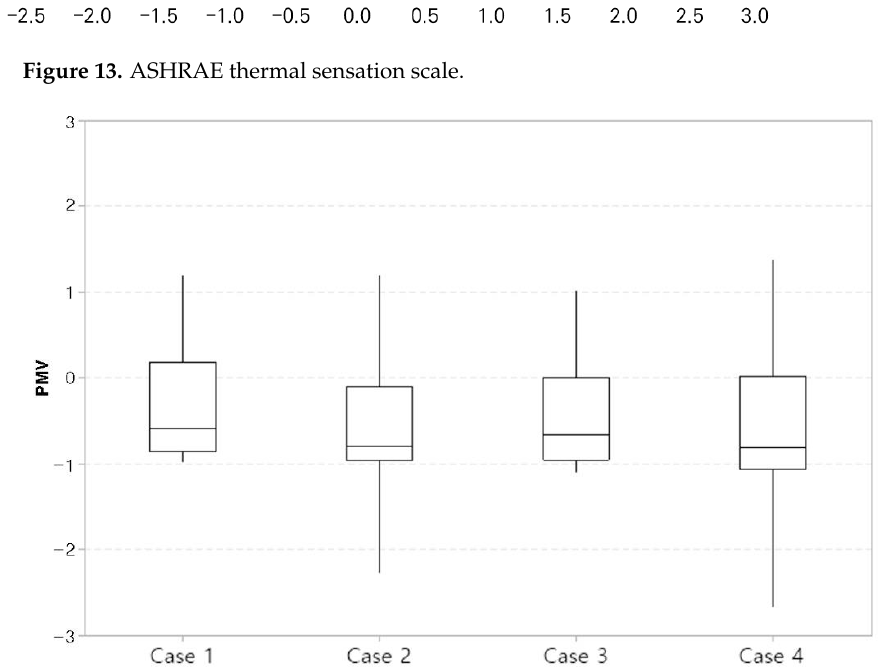
Figure 14. PMV variation by each case.